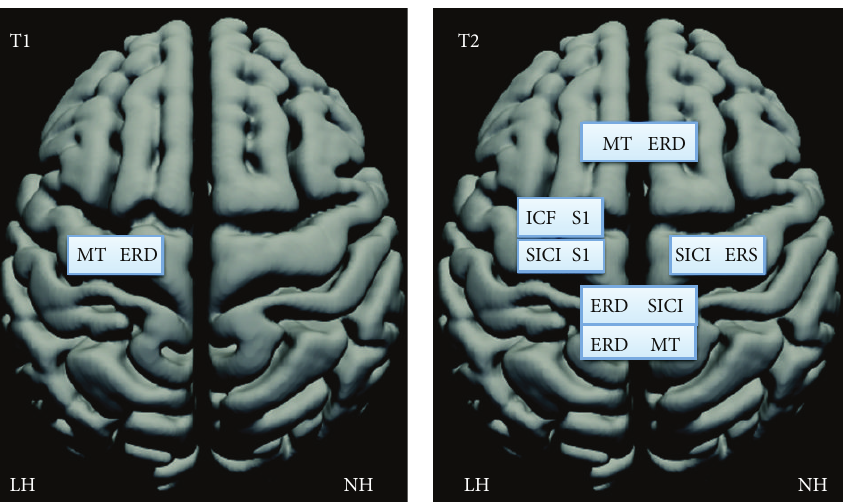
Figure 2: TMS and MEG parameters correlating at T1 (one month) and at T2 (three months), drawn on a schematic brain with lesioned (LH) and nonlesioned hemisphere (NH). The intrahemispheric connections are drawn on one hemisphere and interhemispheric connections on both hemispheres. Note strong increase of both intra- and interhemispheric correlations from one to three months after the